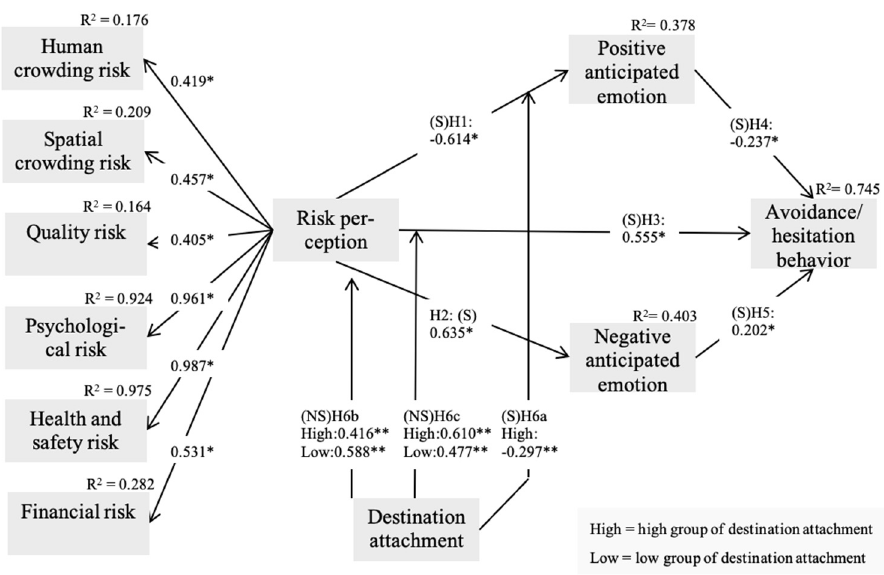
Figure 2. Structural model and invariance model results. Note1. Goodness-of-fit statistics for the structural model (higher-order model χ 2 = 1079.063, df = 337, p < 0.001, χ 2 / df = 3.202, RMSEA = 0.072, CFI = 0.946, IFI = 0.946, TLI = 0.939. Note2. Goodness-of-fit statistics for the baseline model: χ 2 = 1567.221, df = 693, p < 0.001, χ 2 / df = 2.262, RMSEA = 0.054, CFI = 0.925, IFI = 0.925, TLI = 0.918. Note3. * p < 0.05, ** p < 0.01. Note4. Two identical models were proposed (models for high and low groups of destination